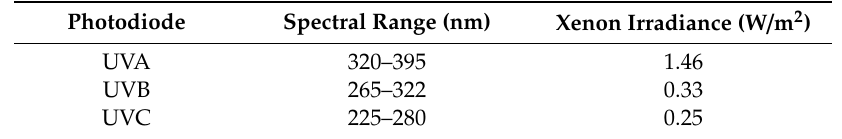
Table 2. Spectral range and Xenon irradiance by the UV photodiodes used in the “RadSensor”.